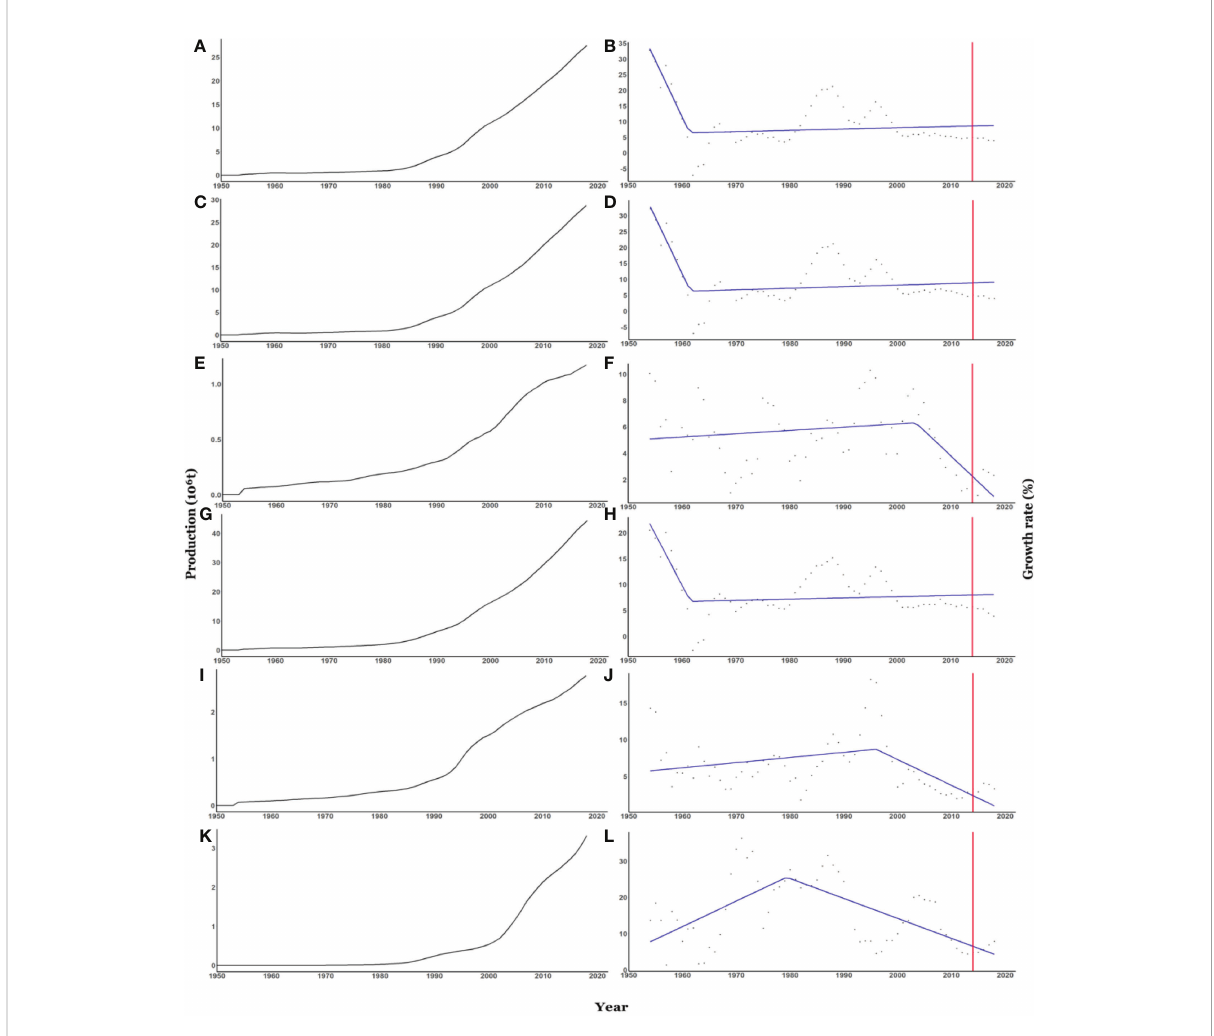
FIGURE 3 Total farmed species production and growth rates. Figures (A, B) illustrates the top ten farmed species; (C, D) the top ten Fed farmed species; (E, F) the top ten Non-fed farmed species; (G, H) fi n fi sh farmed species; (I, J) Bivalves farmed species; (K, L) Invertebrates farmed species). Total production is calculated from 1950-2018, and the growth rate is quanti fi ed as fi ve year-on-year moving average from the peak growth production to 2018. The red line highlights the trends for the last fi ve years (2012-2018). The fi ve year-on-year moving average trends are (B) slope1 = -3.67, slope 2 = 0.05;, R 2 =